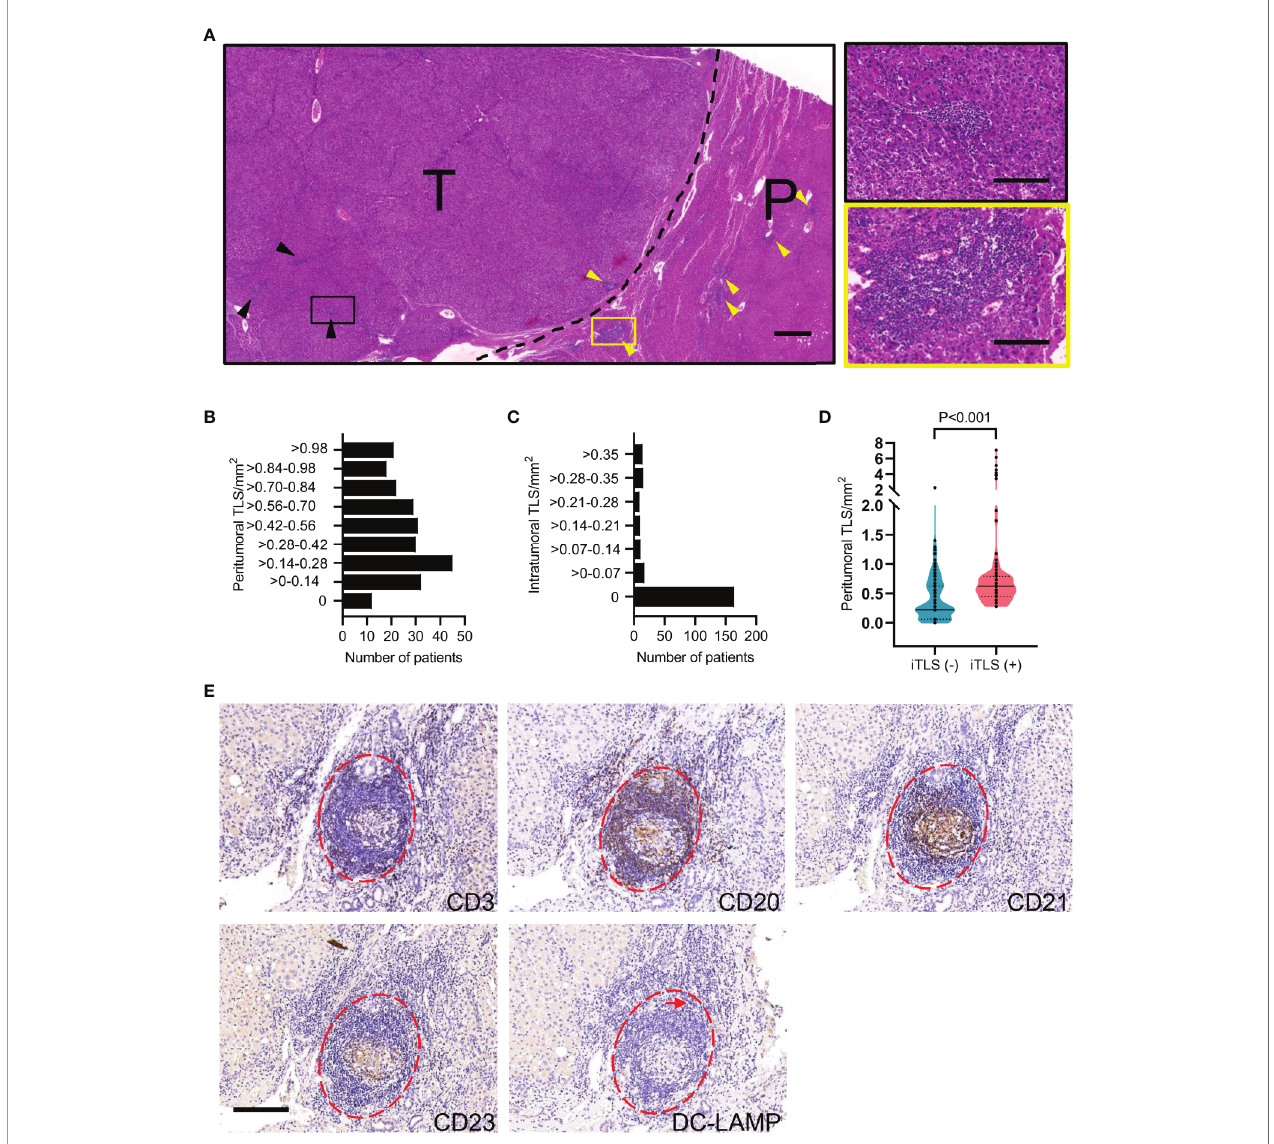
FIGURE 1 | Characterization of HCC-associated TLS. (A) Representative images of H&E-stained HCC tissues showing iTLS (black arrowheads and right zoomed-in segment) in tumor tissue and pTLS (yellow arrowheads and right zoomed-in segment) surrounding the HCC tissues. The black dotted line represents the invasive margin of HCC. Scale bar, left 500 m m; right, 50 m m. (B, C) The density of TLS was determined in peritumoral and intratumoral regions in 240 patients with HCC. (D) The density of pTLS was compared between HCC patients present or absent with iTLS. Groups were statistically compared using Mann – Whitney U-test. (E) Representative images showing components and structure of TLS using consecutive sections. Lymphoid aggregates (red dotted lines) in human HCC specimens are composed of CD3+ T cells, CD20+ B cells, CD21+ FDCs, CD23+ GC cells, and DC-LAMP+ mature DCs (arrow). Scale bar, 100 m m. HCC, hepatocellular carcinoma; T, tumor tissue; P, peritumoral tissue; iTLS, intratumoral tertiary lymphoid structure; pTLS, peritumoral tertiary lymphoid structure; FDC, follicular dendritic cell; GC, germinal center; DC, dendritic